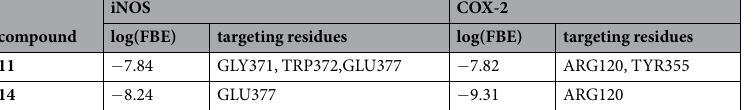
Table 3. Logarithms of Free Binding Energies (FBE, kcal/mol) of the Inhibitors to the Active Cavities of iNOS (PDBcode: 3E7G) and COX-2 (PDB code: 1CX2), and Targeting Residues with Hydrogen Bonding to the Inhibitors in the Binding Site Located on the Mobile